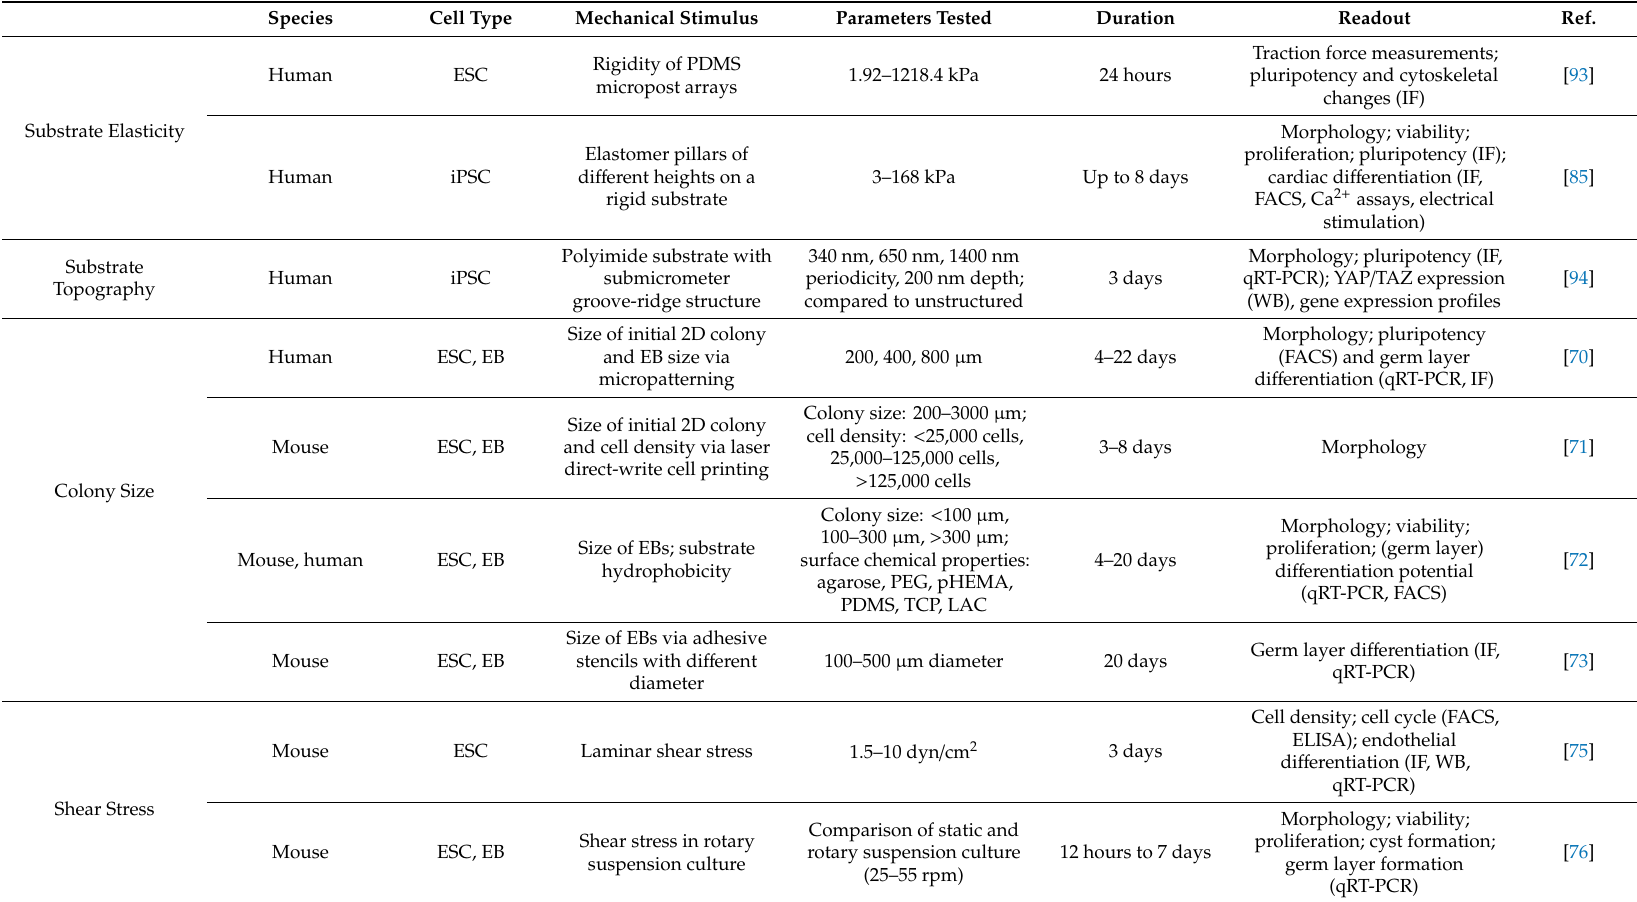
Table 1. Studies on the e ff ect of size and mechanical stimulation on EB di ff